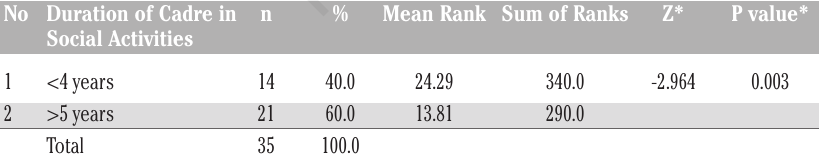
Table 4. The relationship between duration of cadre in social activities and assessing the seller’s performance in Mokoau Health Care Centre Area in 2019.